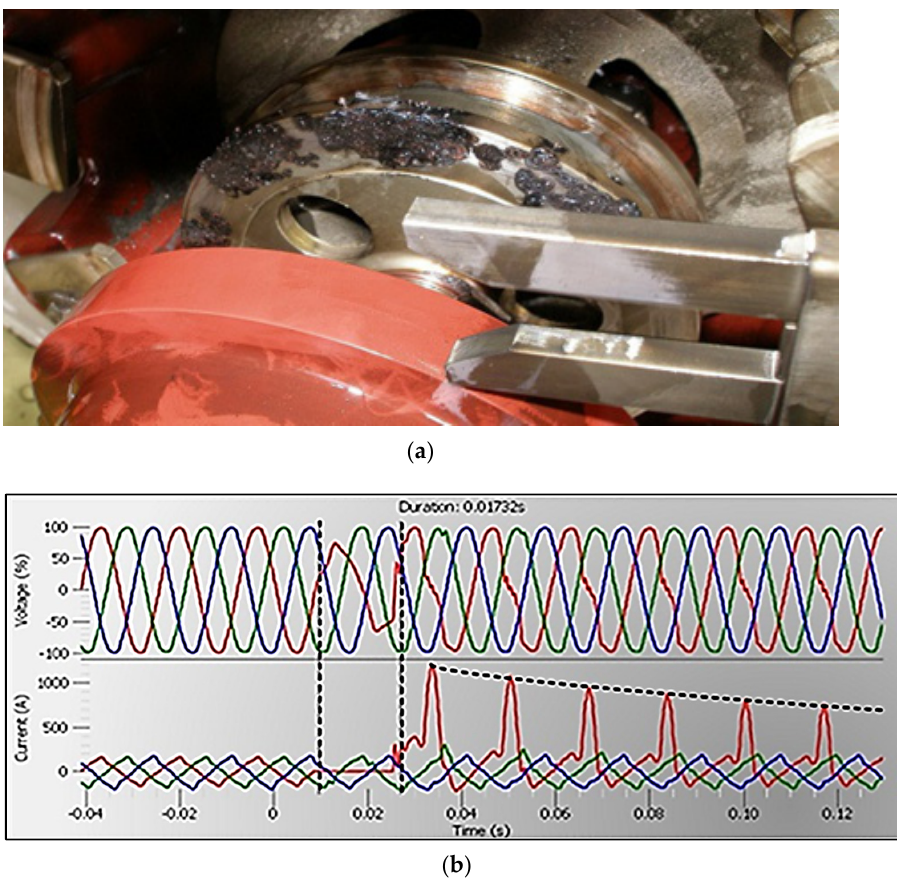
Figure 10. Abnormal condition in the on-load tap-changer ( a ) and current and voltage signals at the transformer terminals ( b ) [37].